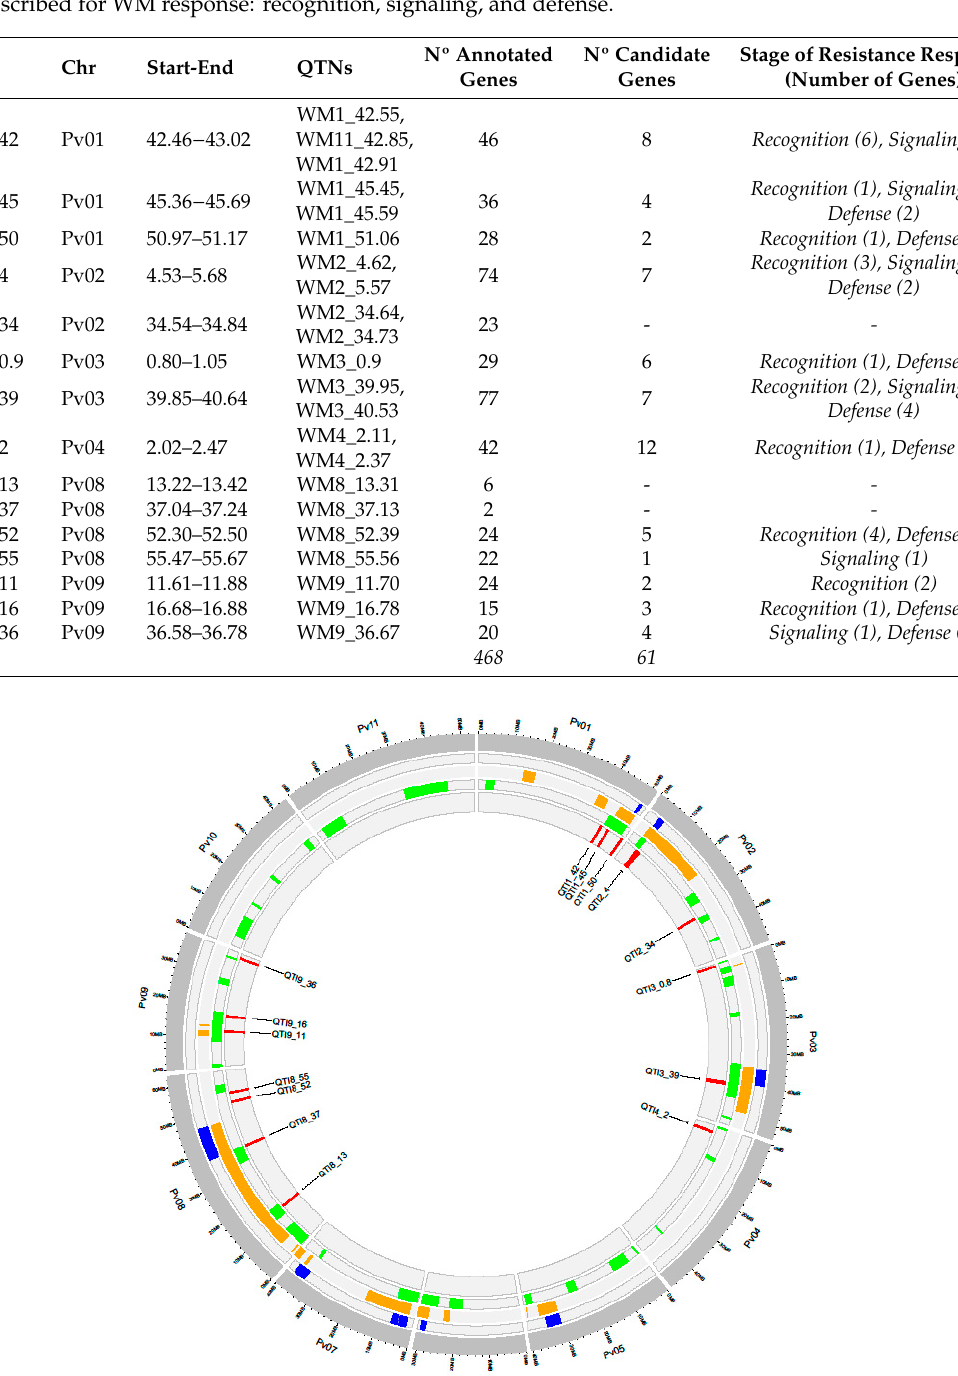
Table 3. QTIs identified in the SDP for resistance to WM. The physical position of each QTI is indicated (chromosome, start, and end position in Mbp). The number of annotated genes and candidate genes underlying each QTI is indicated. Potential candidate genes were grouped in the main three stages described for WM response: recognition, signaling, and defense.